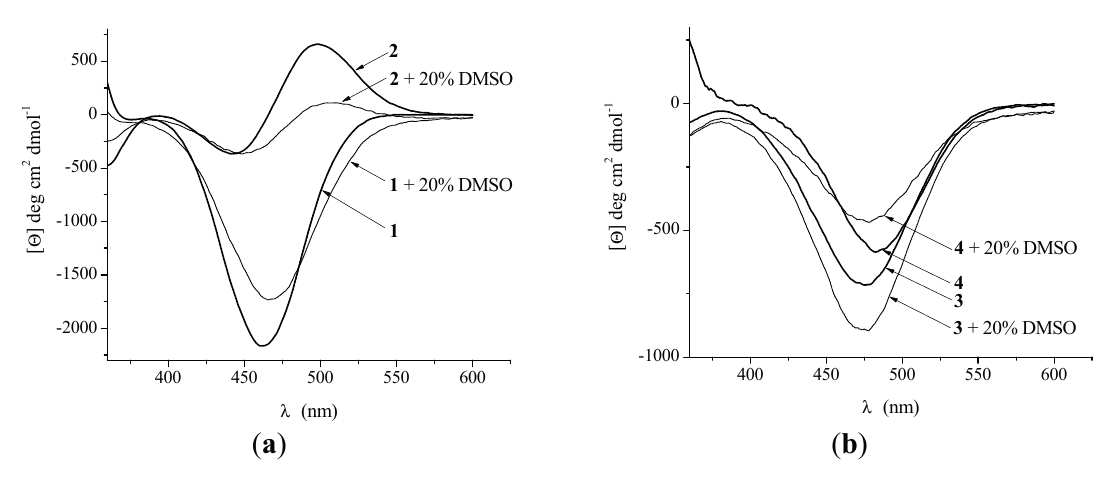
Figure 7. The Cotton effects in chirality-organized ferrocene peptides 1 and 2 ( a ) and 3 and 4 ( b ) in CH Cl ( c = 5 × 10 − 3 M) and CH 2 2